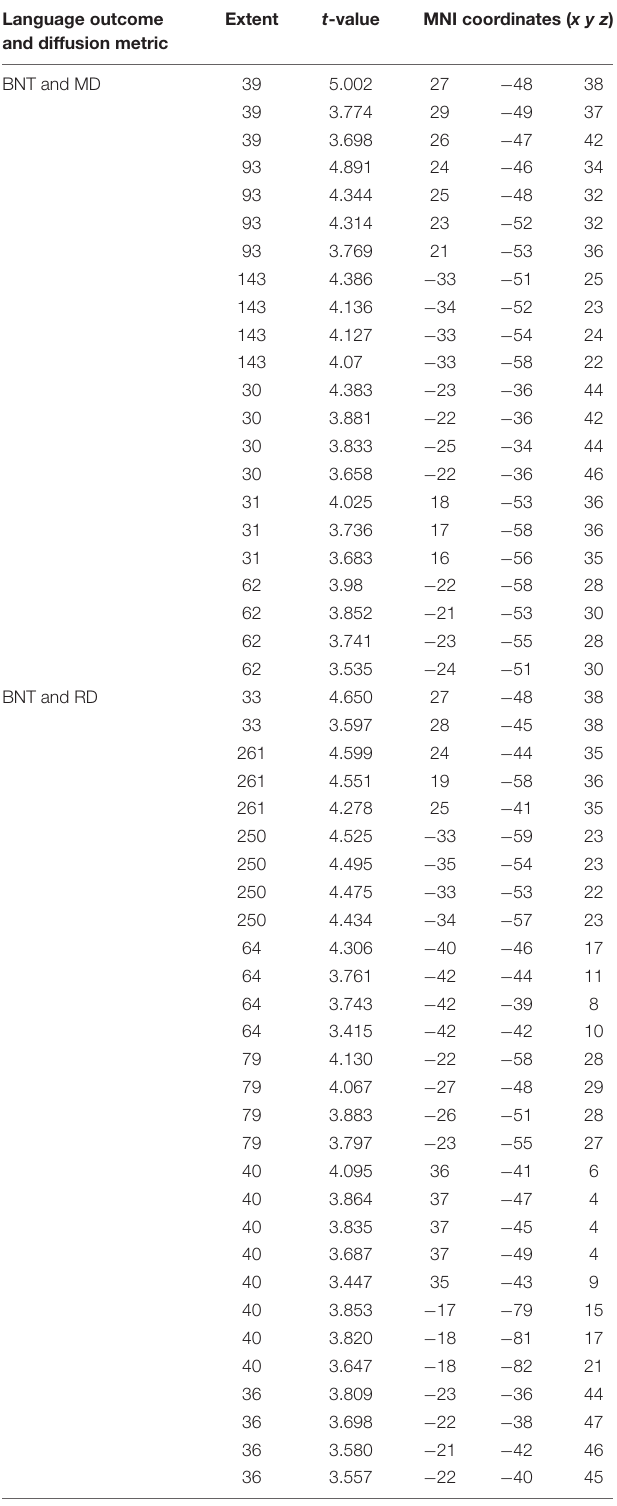
TABLE 5 | Locations of regions showing significant negative relationships between BNT performance and MD (shown in Figure 5A ) and RD (shown in Figure 5B ). Language outcome and diffusion